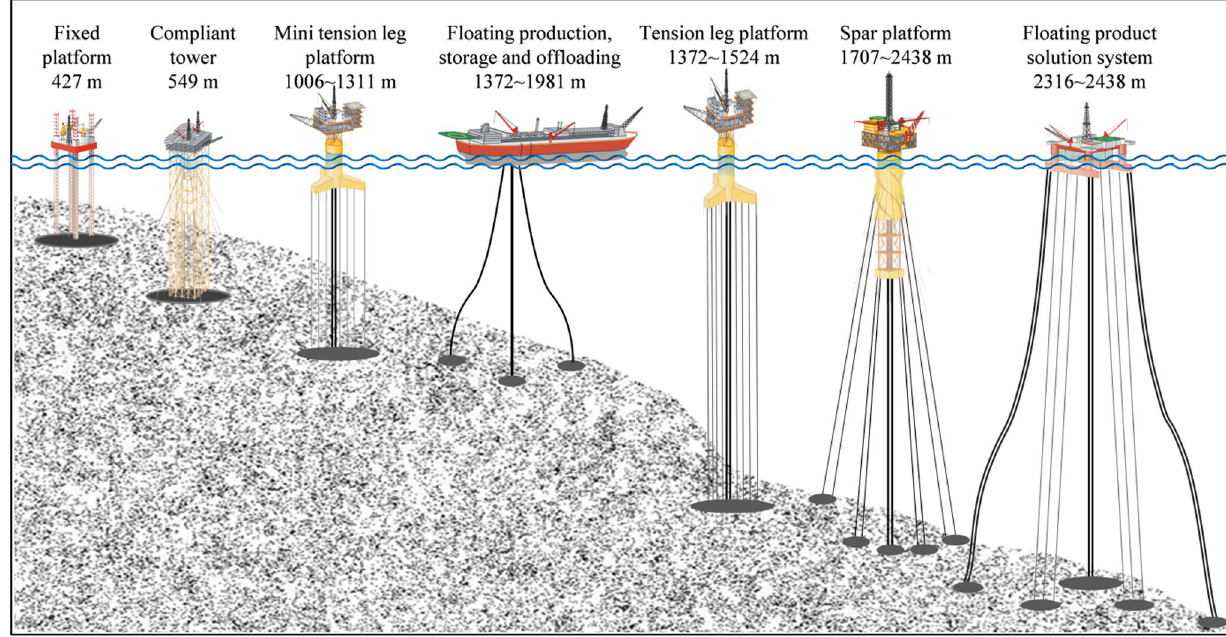
Fig. 14 Examples of resource extraction platforms (modified from Yu et al. 2015 and https:// world ocean review. com/ de/ wor-3/ oel- gas/ wie- und- wo- gefoe rdert-